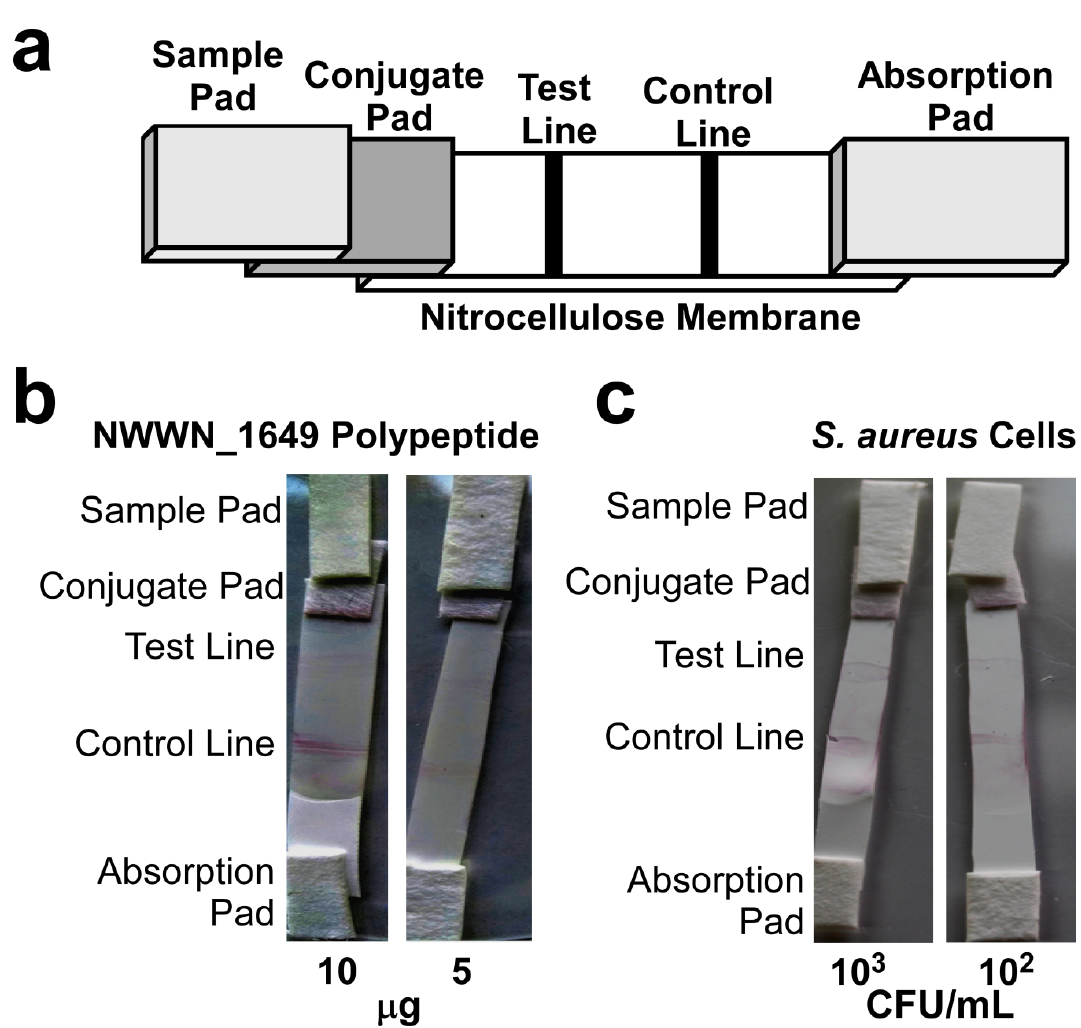
Figure 4. The development of an ICS that can detect both the purified polypeptide and whole cells. ( a ) Schematic diagram showing the design of the developed ICS showing the position and the arrangement of the different components of the strip. ( b ) Photographs of the developed ICS upon testing using different aliquots containing two amounts of the purified polypeptide. ( c ) Photographs of the developed ICS upon testing using aliquots containing two different concentrations of the S. aureus cells suspension. In both cases, the sample volume was 150 µL which were loaded on the sample pad and allowed to flow for 10–15 min at room temperature.